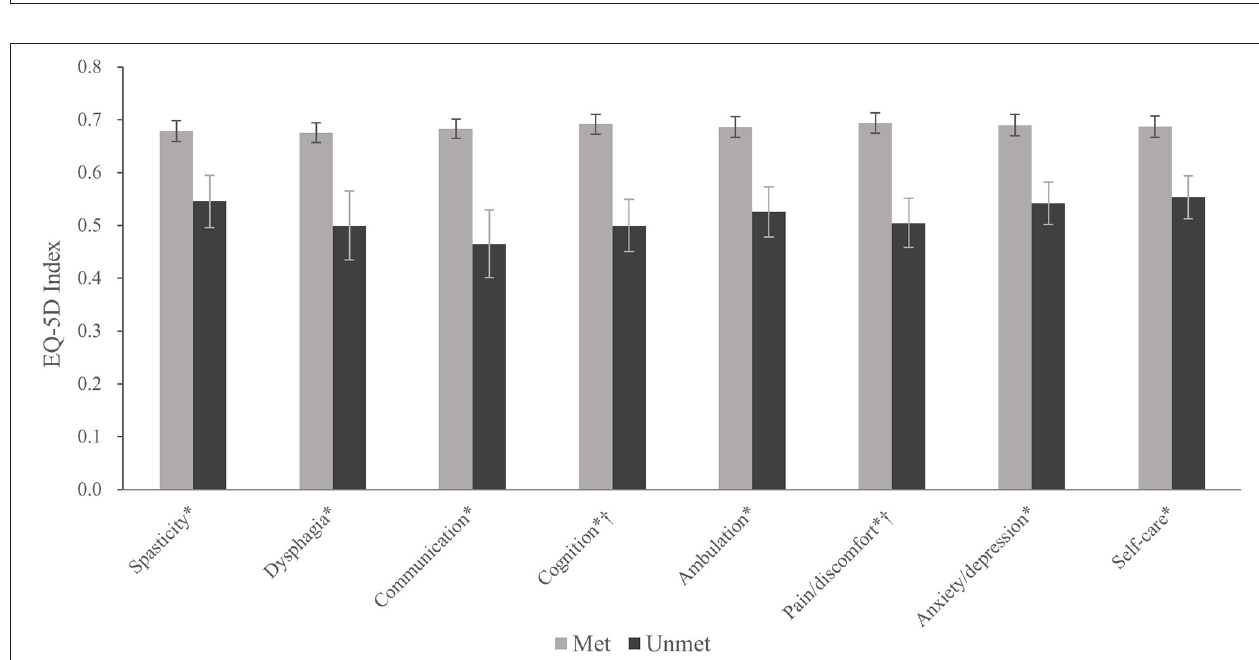
FIGURE 2 | EQ-5D index according to the presence of unmet need for each common problem after stroke. Values are presented as the mean and standard error. * p < 0.05, after adjusting for age and sex. † p < 0.05, after adjusting for age, sex, and modified Rankin Scale.